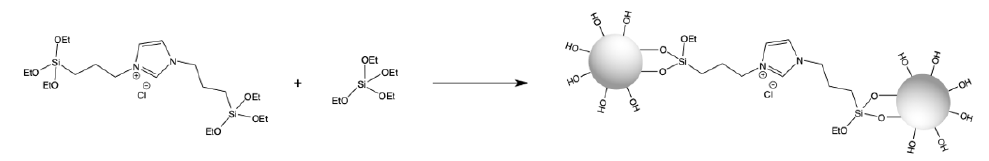
Figure 5. Covalently immobilized ionic liquid via the sol-gel method.